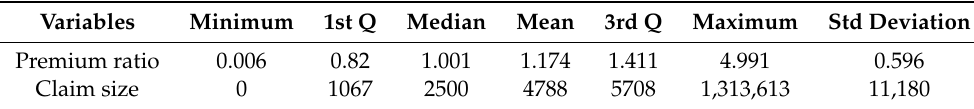
Figure 3. Relationship between log of claim size and premium ratio according to Switch. Table 4. Summary statistics of premium ratio and claim